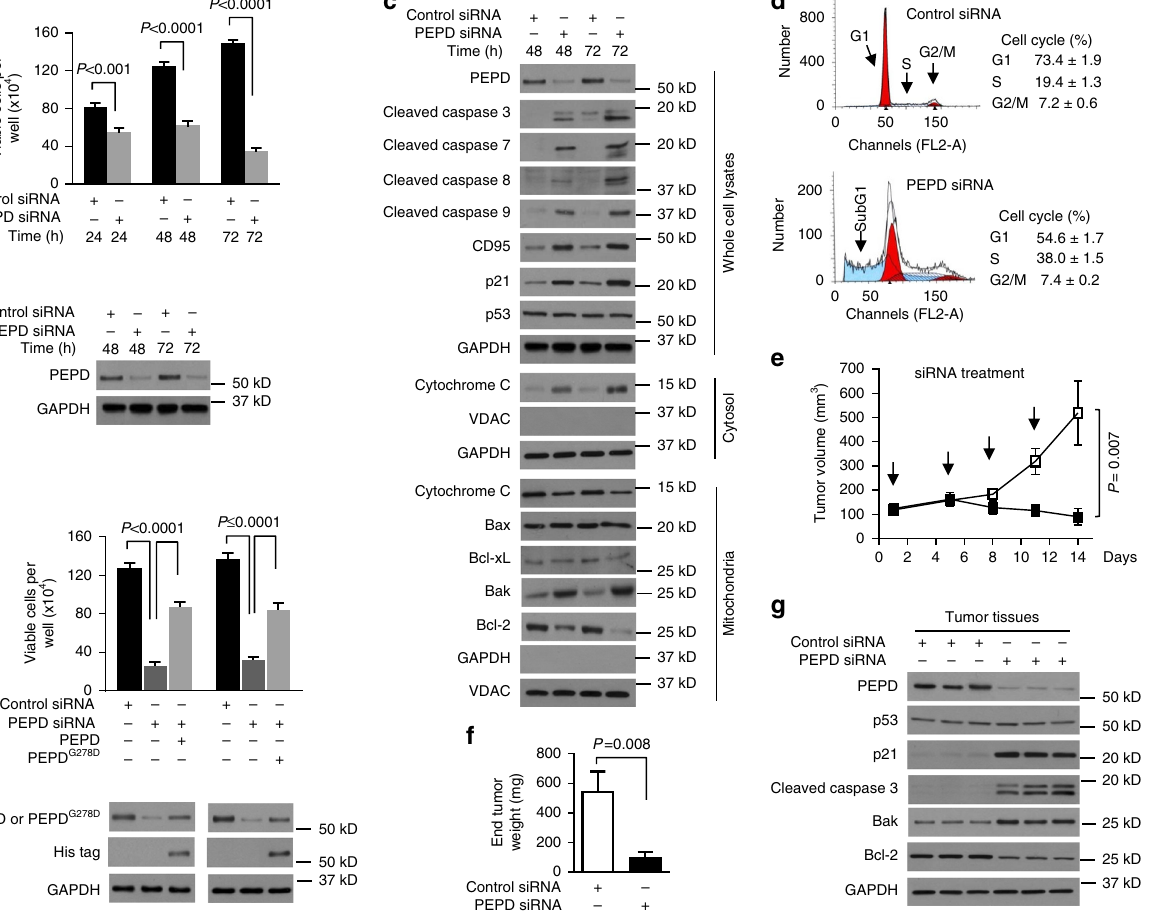
Fig. 1 PEPD is essential for cell survival in vitro and in vivo. a Measurement of UM-UC-3 cell viability and IB analysis of PEPD after siRNA treatment. b Measurement of UM-UC-3 cell viability and IB analysis of PEPD after siRNA treatment for 24 h and then treatment with or without PEPD or PEPD G278D (His-tagged) for 48 h. c IB analysis of various proteins in UM-UC-3 cells after siRNA treatment. d UM-UC-3 cell cycle analysis by fl ow cytometry after siRNA treatment for 72 h. e , f UM-UC-3 tumor growth in athymic nude mice after intratumoral injection of control siRNA (open square) or PEPD siRNA ( fi lled square) at the indicated times (arrows) and fi nal tumor weight. g IB analysis of various proteins in tumors from 3 mice/group obtained on day 14. GAPDH and VDAC were measured to ensure the purity of subcellular fractions or as loading controls. Cells were cultured in 6-well plates (5 × 10 4 cells/ well) for 24 h before experimental treatment in a – d. Data are means ± s.d. ( n = 3) in a , b , and d (two-way ANOVA followed by Tukey multiple comparisons test) and means ± s.e.m. ( n = 8) in e and f (two-tailed t